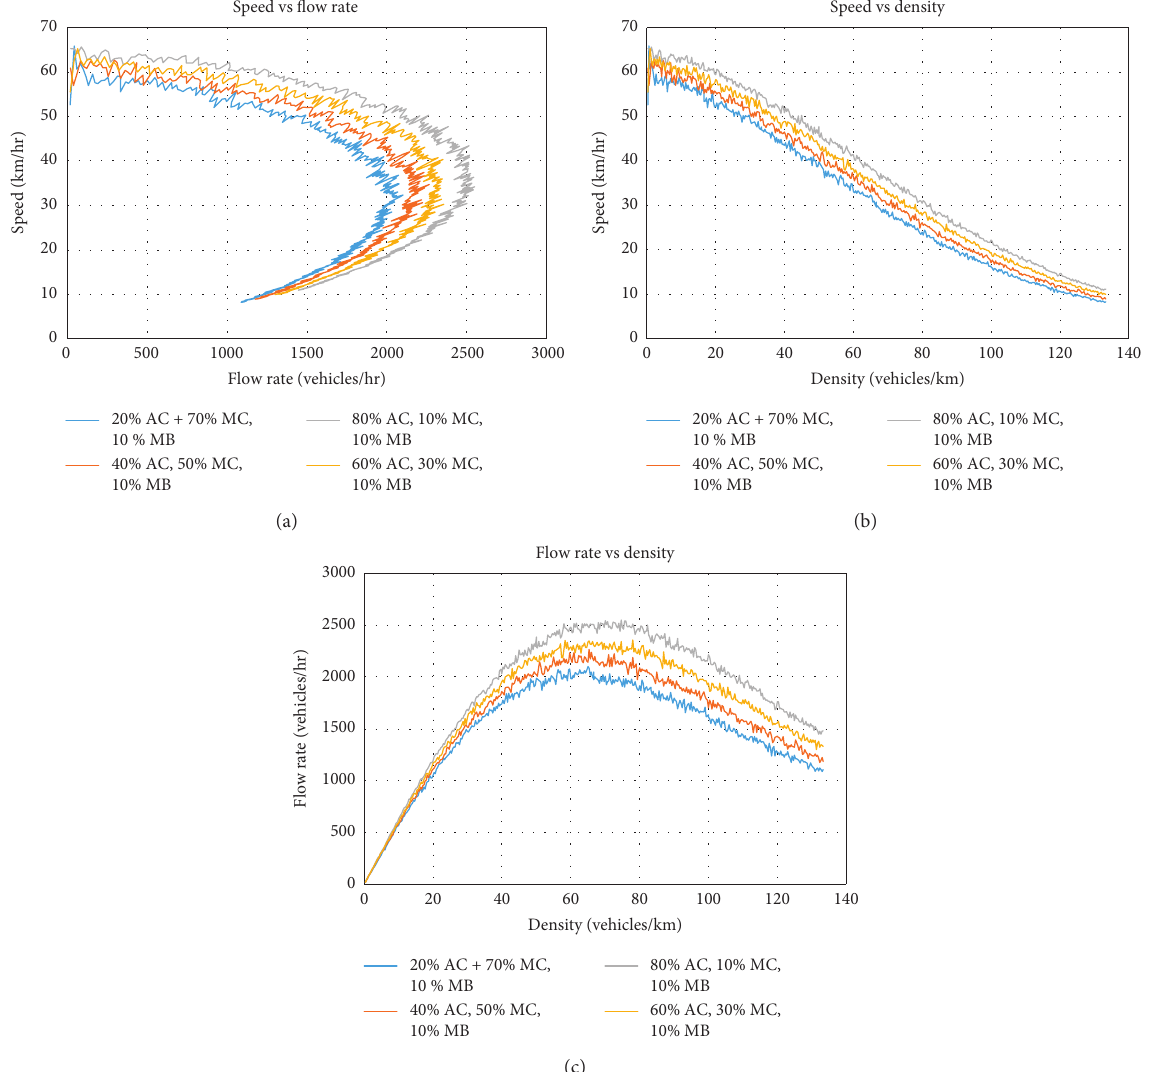
Figure 4: Traffic flow fundamental diagrams for different compositions of AC, MC, and